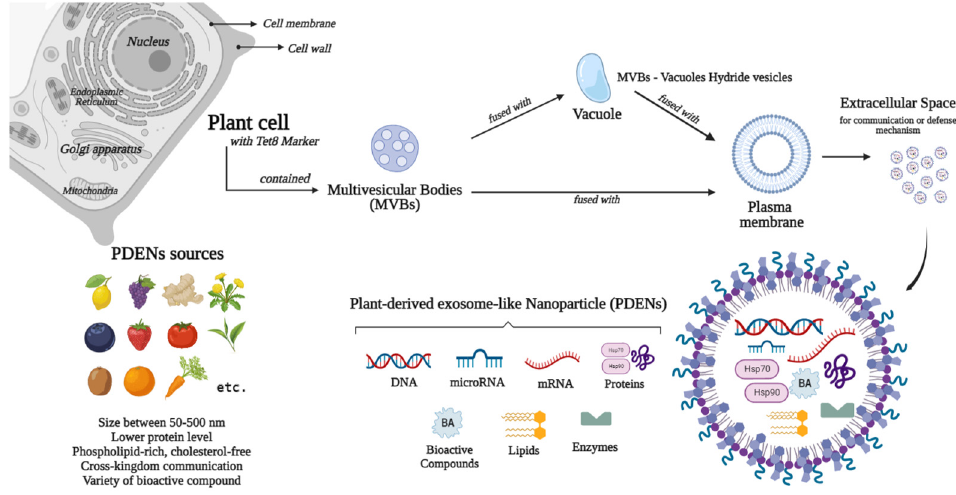
Figure 1. Sources, biogenesis, and contents of plant-derived exosome-like nanoparticles (PDENs).